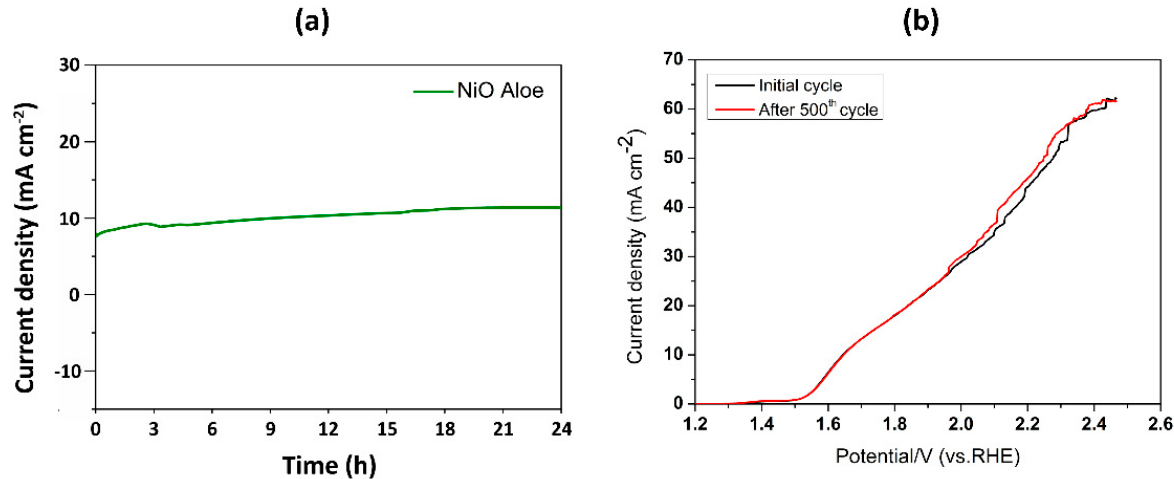
Figure 9. ( a ) Chronoamperometric stability tests at 1.65 V (vs the RHE) and ( b ) LSV curves obtained before and after 500 CV cycles of aloe-vera-mediated NiOx NPs.